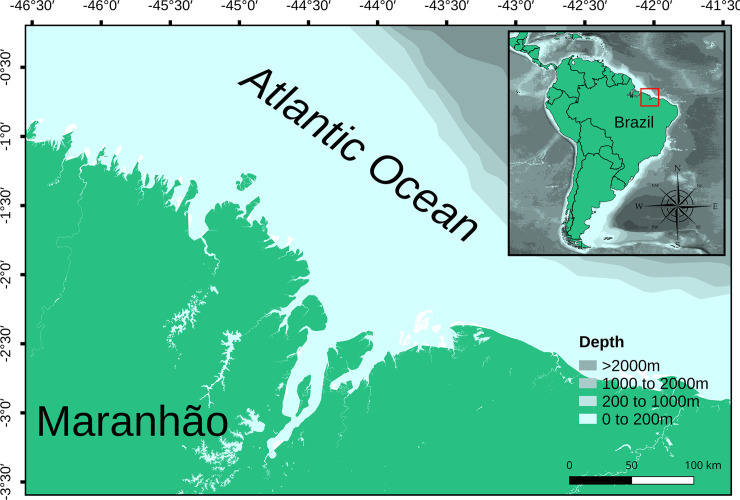
Location of Carcharhinus porosus catches in Maranhão state’s coast.Light blue areas correspond to the 200 m isobaths followed by the 1000 m, 2000 m and above 2000 m depth.